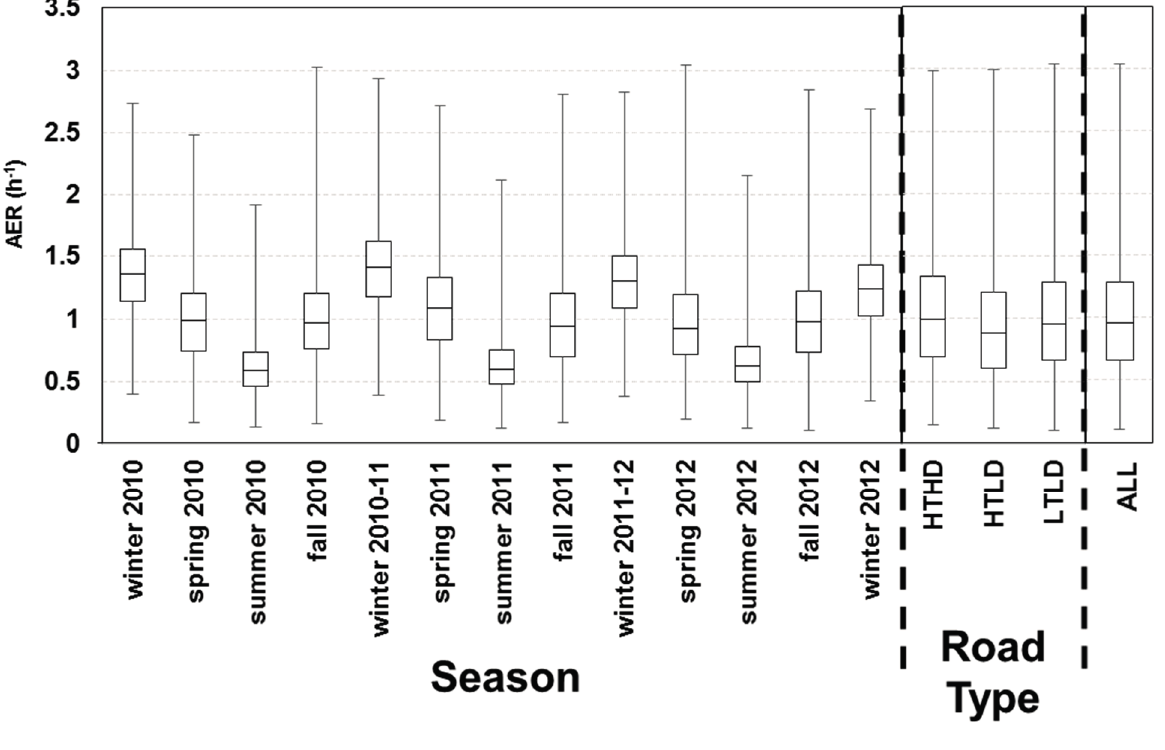
Figure 6. AER predictions for 213 homes across the three years of the health study with results for individual homes grouped by the three traffic categories: HTHD ( A ), HTLD ( B ), and LTLD ( C ). Box plots show median, 25th and 75th percentiles, and whiskers represent minimum and maximum values of 24 h average